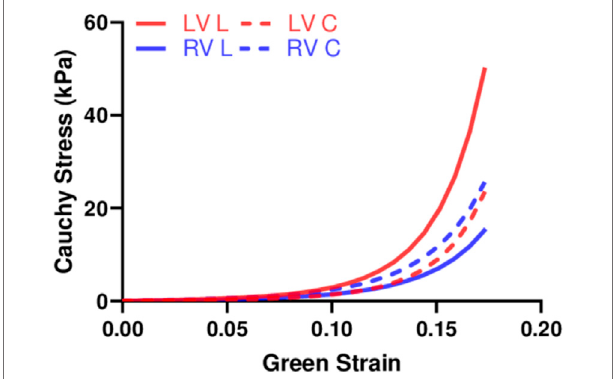
FIGURE 4 | Simulated equibiaxial stress-strain curves generated by the four-parameterFungmodel,usingtheaveragevaluesofthe fi ttingparameters for both ventricles in two